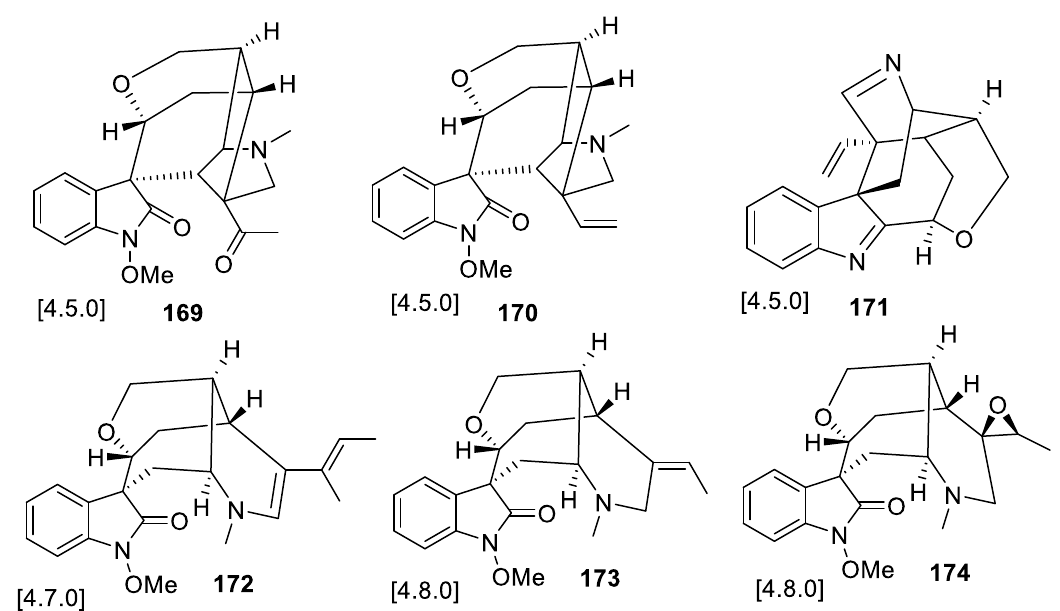
Figure 82. Structurally diverse spirocyclic frameworks isolated from a single plant species ( Gelsemium elegans ).